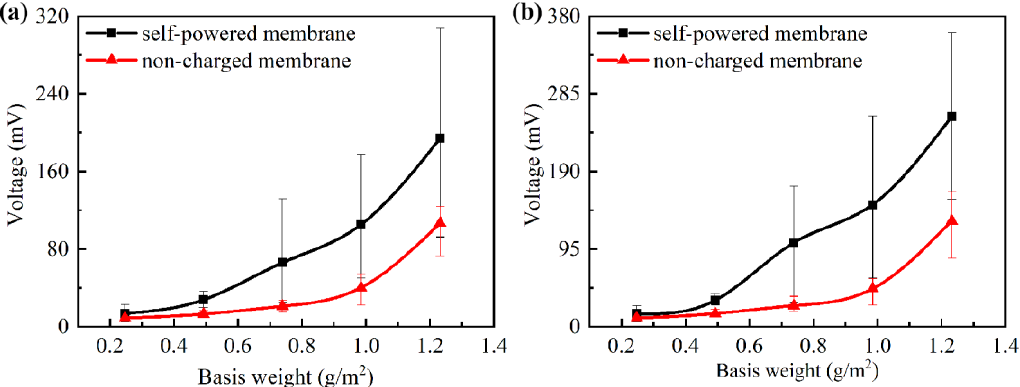
Figure 5. The measured voltage on the two sides of the composite membranes of different combinations under different airflow velocities: ( a ) 0.1 m/s and ( b ) 0.15